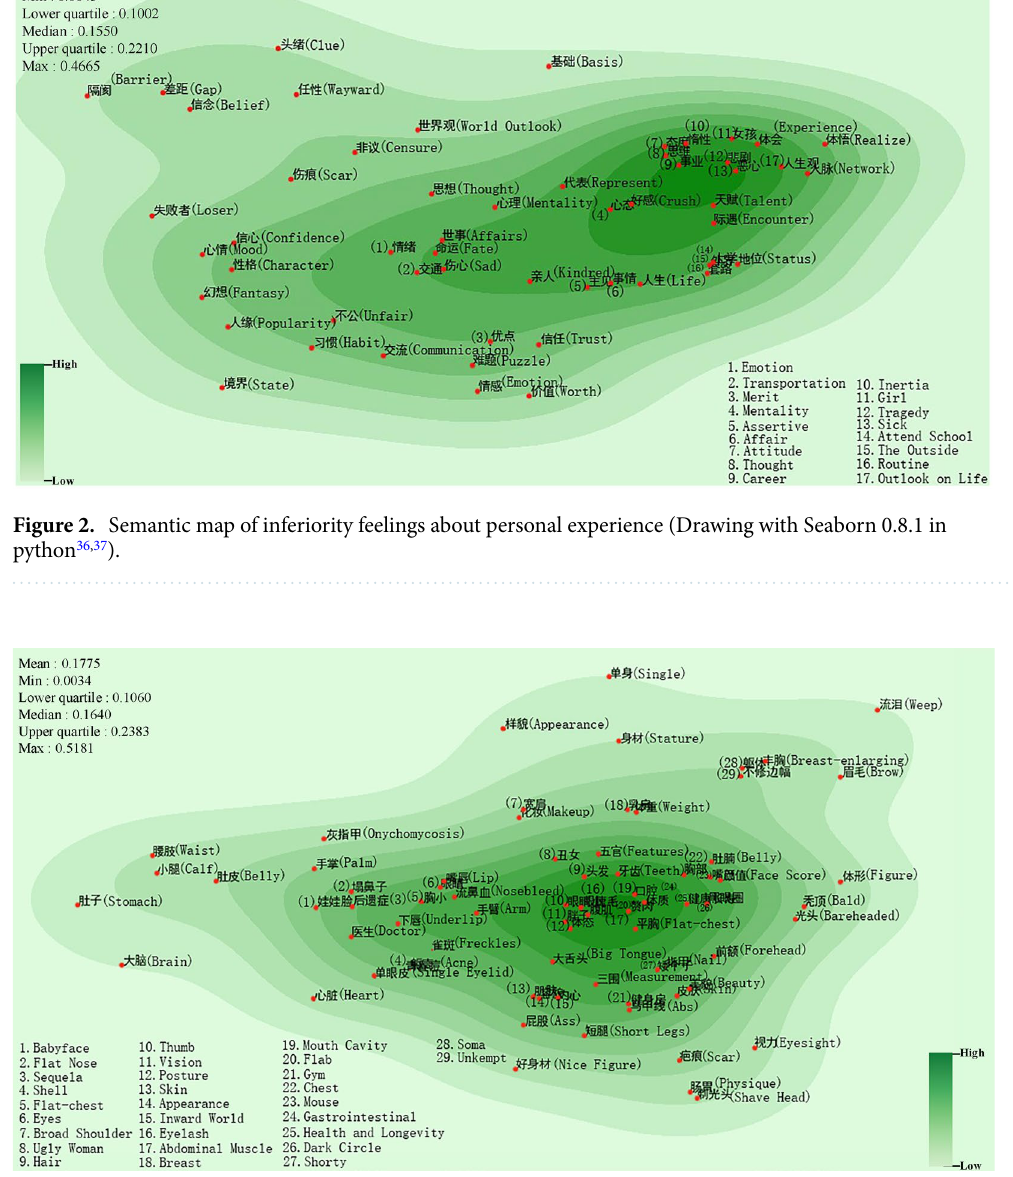
Figure 3. Semantic map of inferiority feelings about physical defects (Drawing with Seaborn 0.8.1 in python 36,37